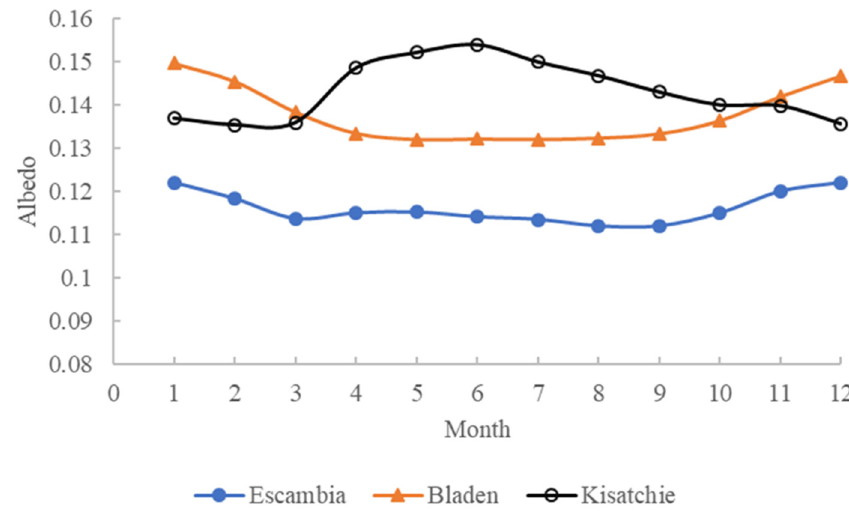
Figure 8. The integrated monthly average of albedo in Escambia, Bladen, and Kisatchie.